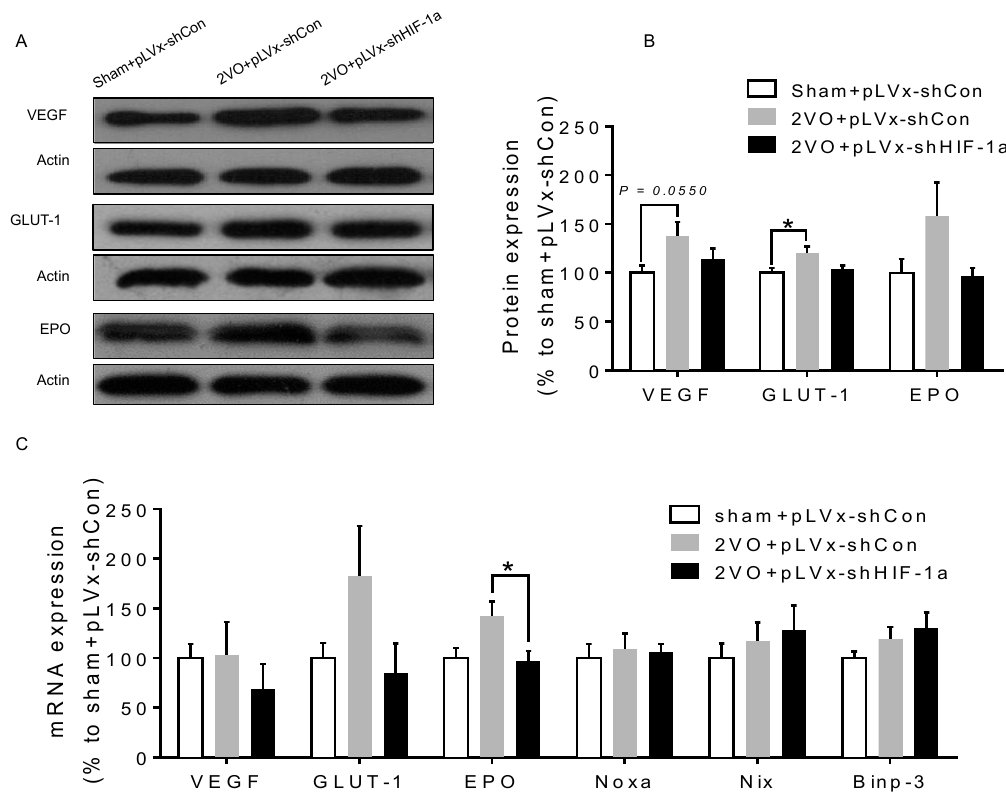
Figure 7. The effects of HIF-1 α knockdown on the expression of downstream genes during CCH. ( A , B ) Western blot analysis of VEGF/GLUT-1/EPO protein levels in hippocampus four weeks following 2VO or sham operation with or without HIF-1 α knockdown; ( C ) qRT-PCR analysis VEGF/GLUT-1/EPO and Noxa/Nix/Binp -3mRNA levels in hippocampus of rats in each group. Values